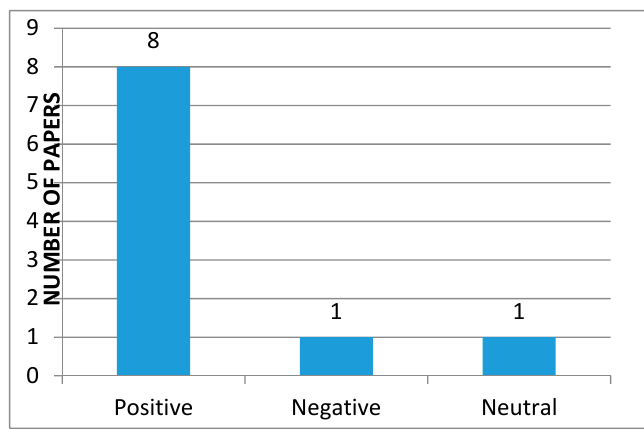
Figure 2. Impact of ISO 14001 on GSCM.